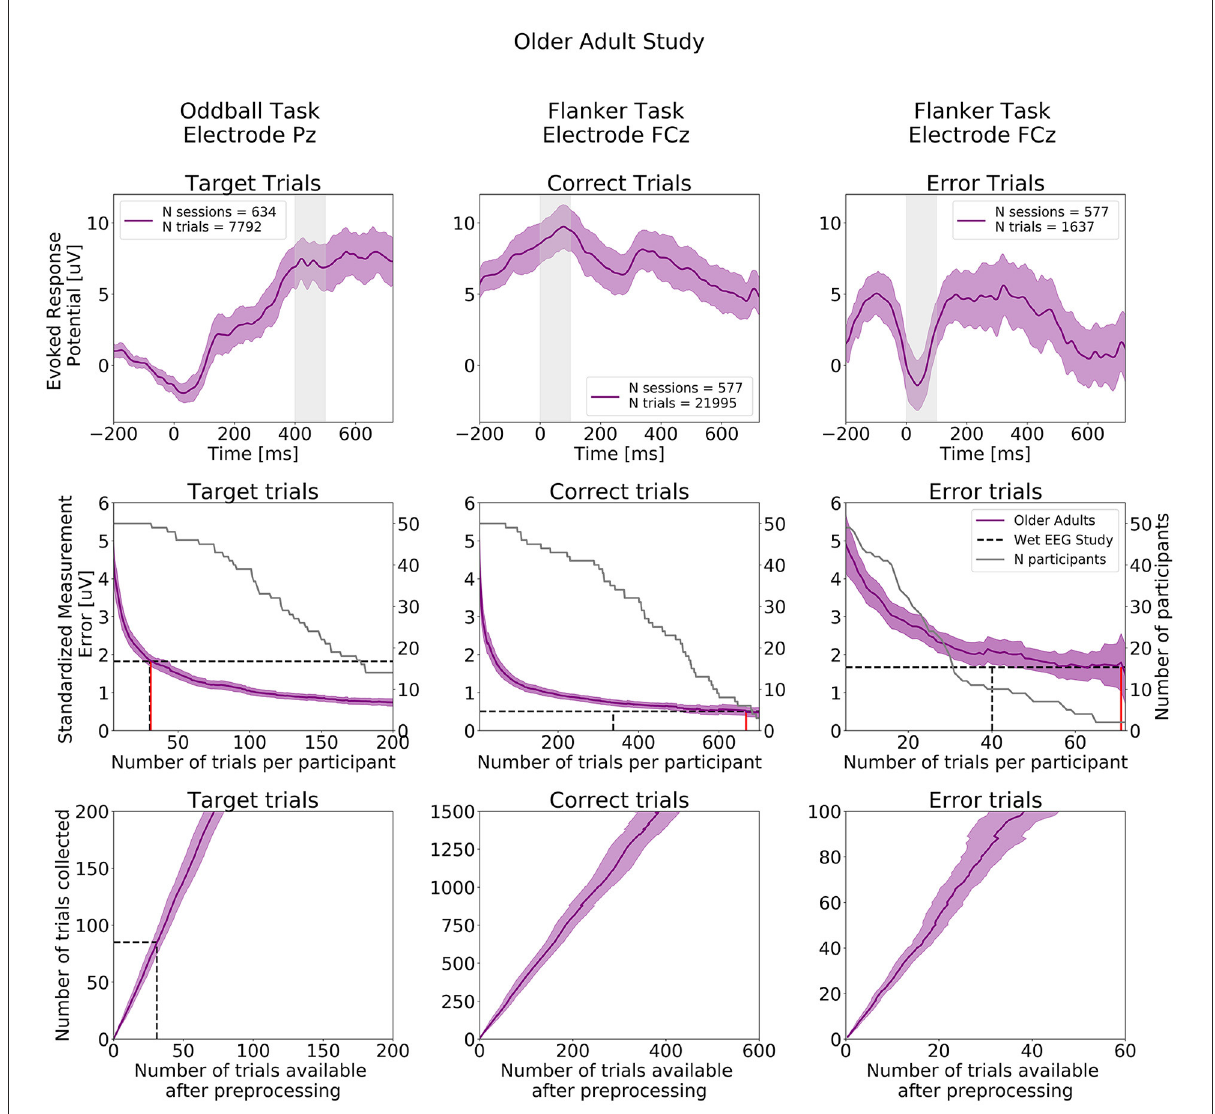
FIGURE9 ERPs analyses extracted from the Older Adult Study ( N 50). Top row: Grand study average computed across all participants. Middle row: = Standardized Measurement Errors per number of trials. The gray continuous lines correspond to the number of participants remaining in the SME calculation after trial rejection. Bottom Row: Mean numbers of trials available after preprocessing. The black dotted lines correspond to the mean numbers of trials extracted from the wet EEG study. From left to right: Target Trials extracted from the Oddball task at electrode Pz, Correct Trials extracted from the Flanker task at electrode FCz, Error Trials extracted from the Flanker task at electrode FCz. The shaded areas correspond to the 95% confidence